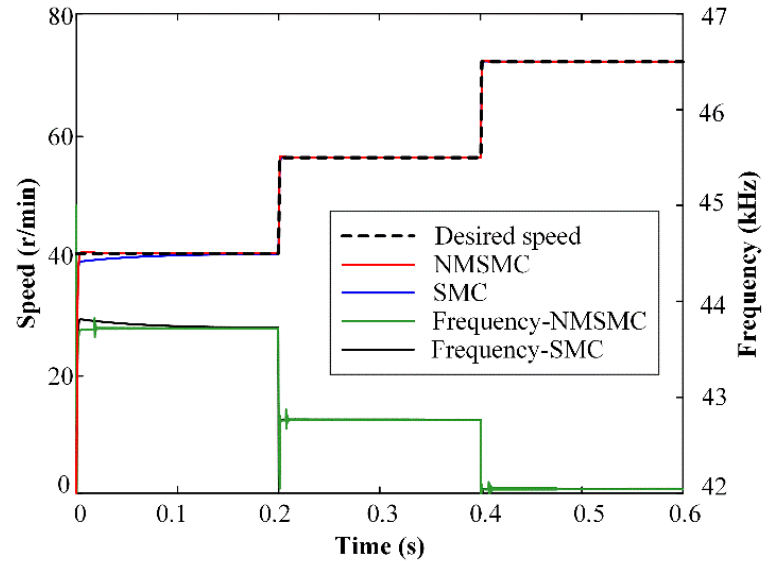
Figure 7. Simulation results of varying speed control for SMC and NMSMC.